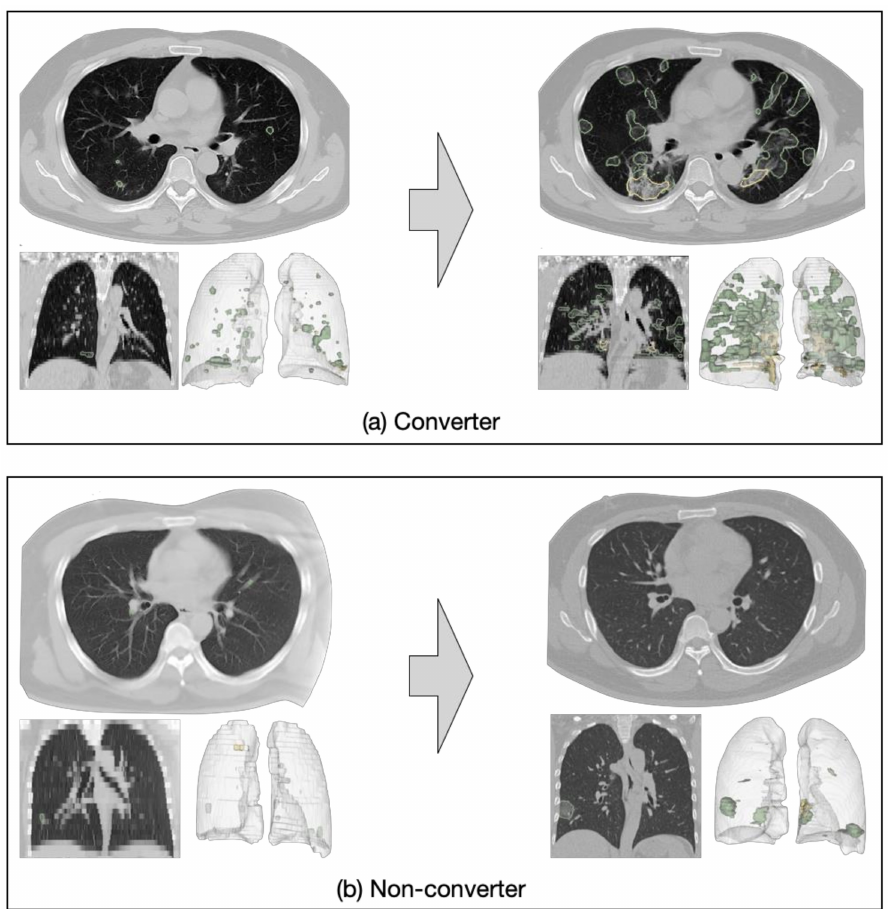
Figure 1. Examples of converter and non-converter cases. ( a ) A mild case progressed to severe within seven days; ( b ) a mild case did not progress to severe within seven